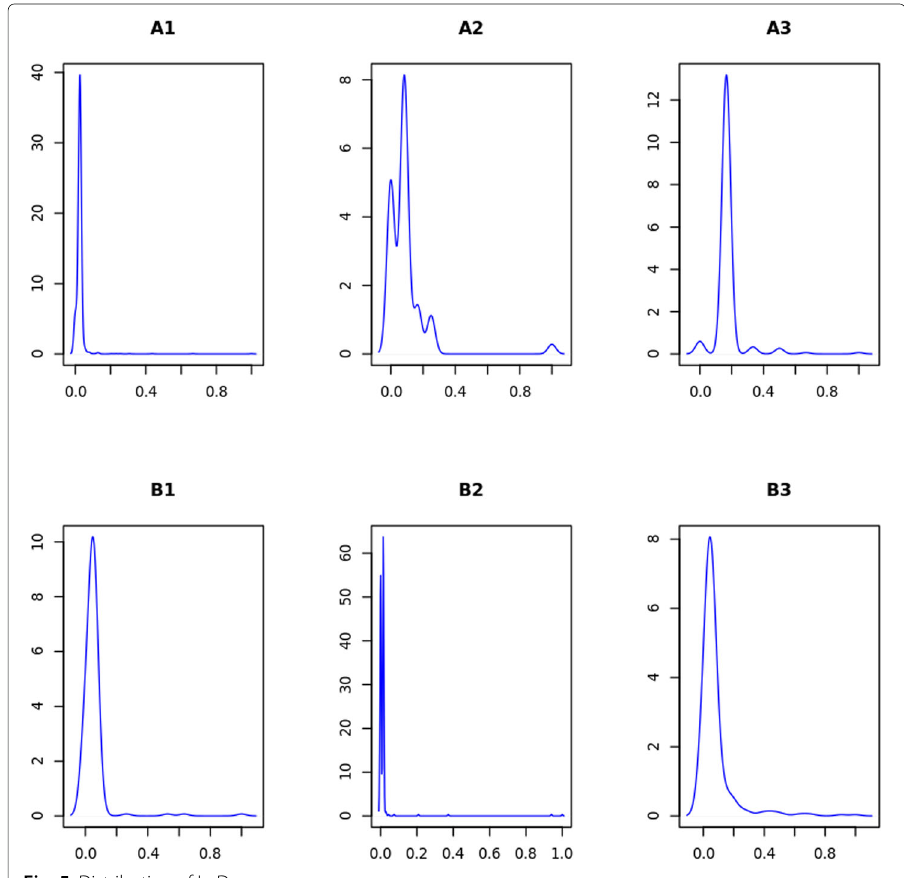
Fig. 5 Distribution of In Degree